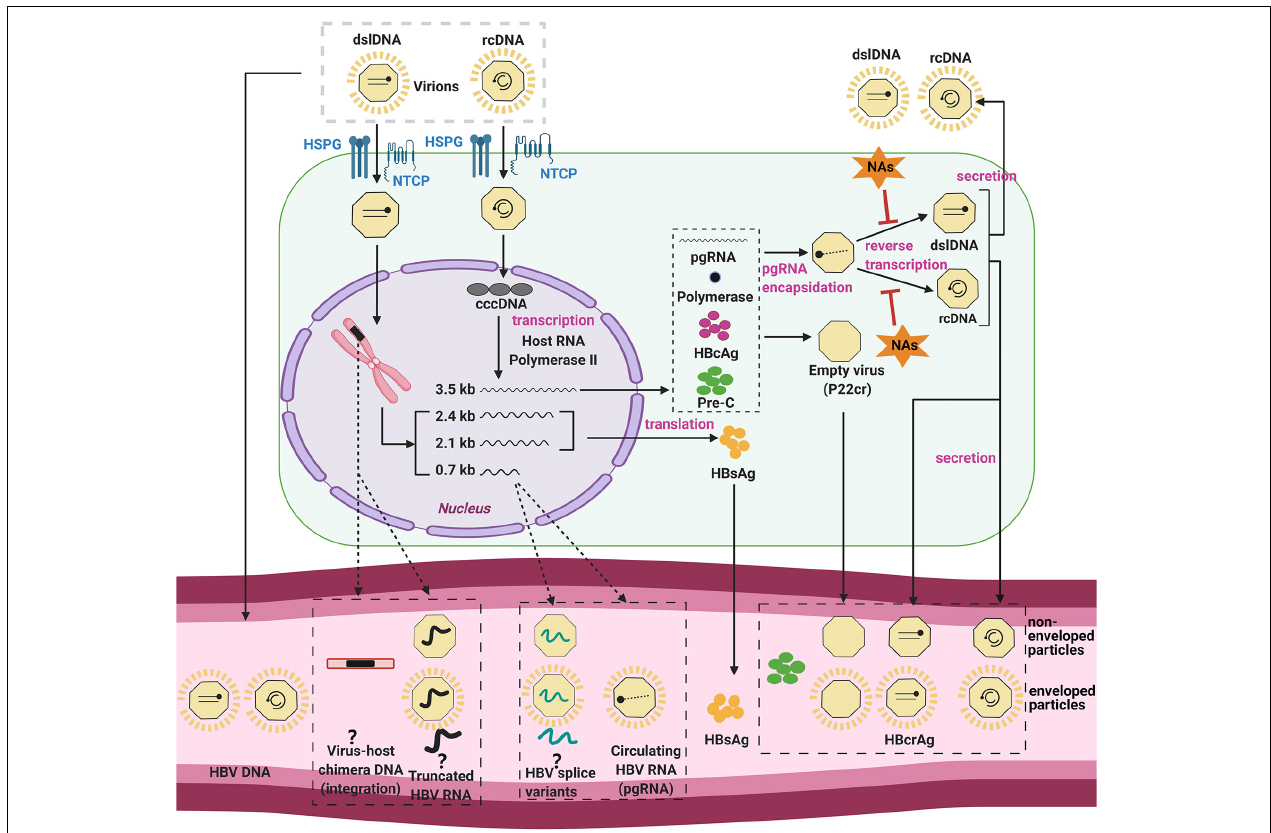
FIGURE 1 | The HBV replication cycle and its secreted products. The HBV virion enters the hepatocyte by NTCP receptor binding, and uncoats prior to entry into the cytoplasm. The viral nucleocapsid is then transported to the nucleus, where it deposits its DNA genome. HBV relaxed-circular DNA (rcDNA) genomes can be repaired and ligated to form cccDNA, the template for all viral RNAs. HBV core antigen (HBcAg) is translated and forms capsids, some of which form around the pregenomic RNA (pgRNA) and viral polymerase. The pgRNA is reverse-transcribed to form either double stranded linear DNA (dslDNA) or rcDNA forms of the virus genome. The mature nucleocapsid is then enveloped by host membranes studded with HBV surface antigen (HBsAg) and secreted at multi-vesicular bodies. Cytoplasmic HBV capsids are recycled at a poor efficiency to the nucleus and do not appear to significantly add to the cccDNA pool (Tu and Urban, 2018; Revill et al., 2020; Tu et al., 2021). In a secondary pathway, HBV dslDNA can integrate into the host genome at host DNA breaks or form defective cccDNA (not shown). Some of these viral components are released in the serum (bottom) by as yet unclear mechanisms (dashed arrows) including within apoptotic bodies of dying hepatocytes, secretion through alternate pathways, or within exosomes. Even the form in which some of these biomarkers exist in the serum is still unknown and controversial (question marks). Figure was generated using Biorender